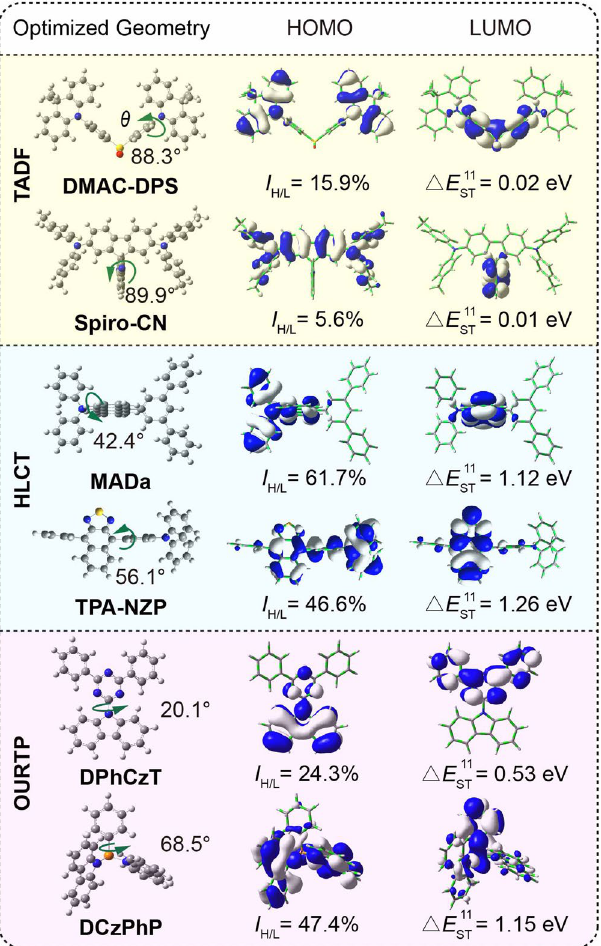
Figure 3. Optimized molecular geometry, frontier orbital electronic density distribution (isovalue = 0.02), I H/L , and Δ E ST11 of the selected TADF, HLCT and OURTP